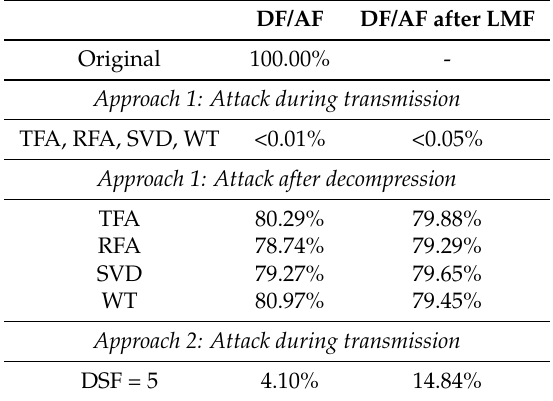
Table 3. NILM (non-intrusive load monitoring) results of privacy protection